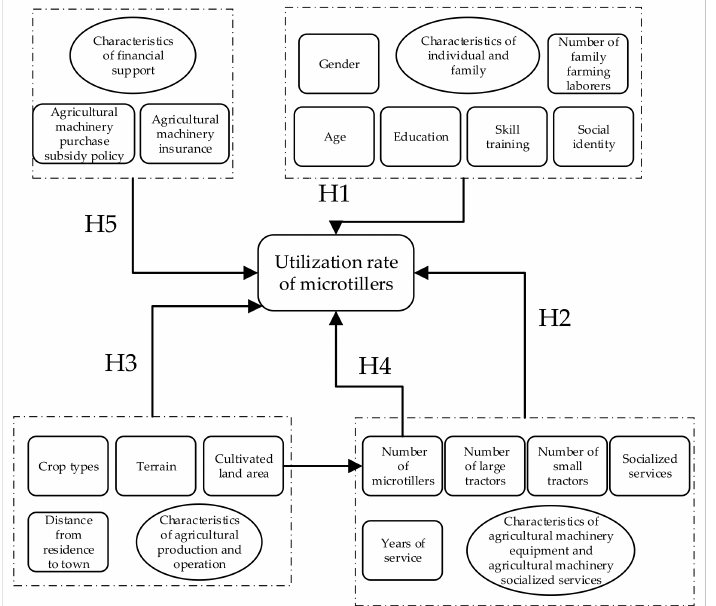
Figure 1. Mechanism analysis of the utilization rate and influencing factors of